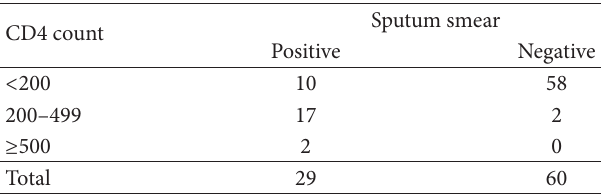
T 3: Relationship between levels of CD4 count and sputum